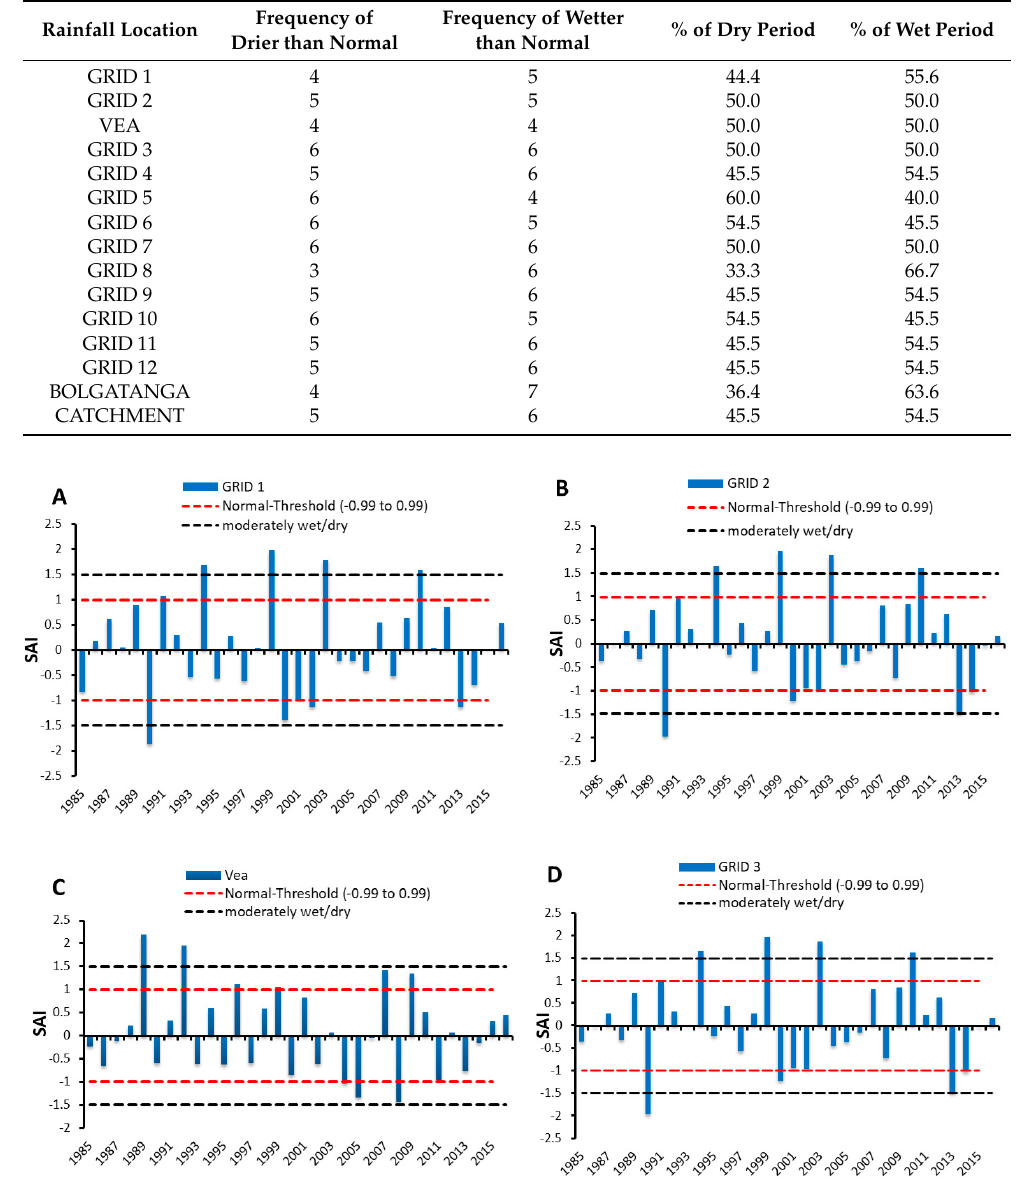
Table 5. Distribution of wetter and drier periods for the different locations within the Vea catchment. Rainfall Frequency of Drier Frequency of Location than Normal Rainfall Location